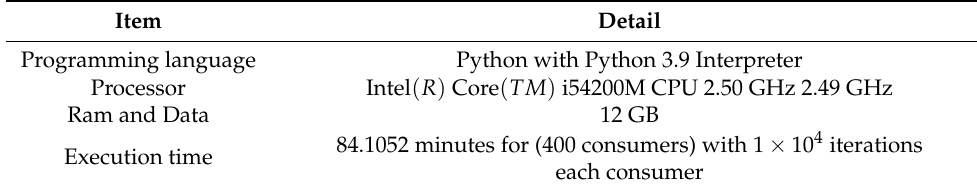
Figure 22. Load variation evaluation. Table 5. This is a table